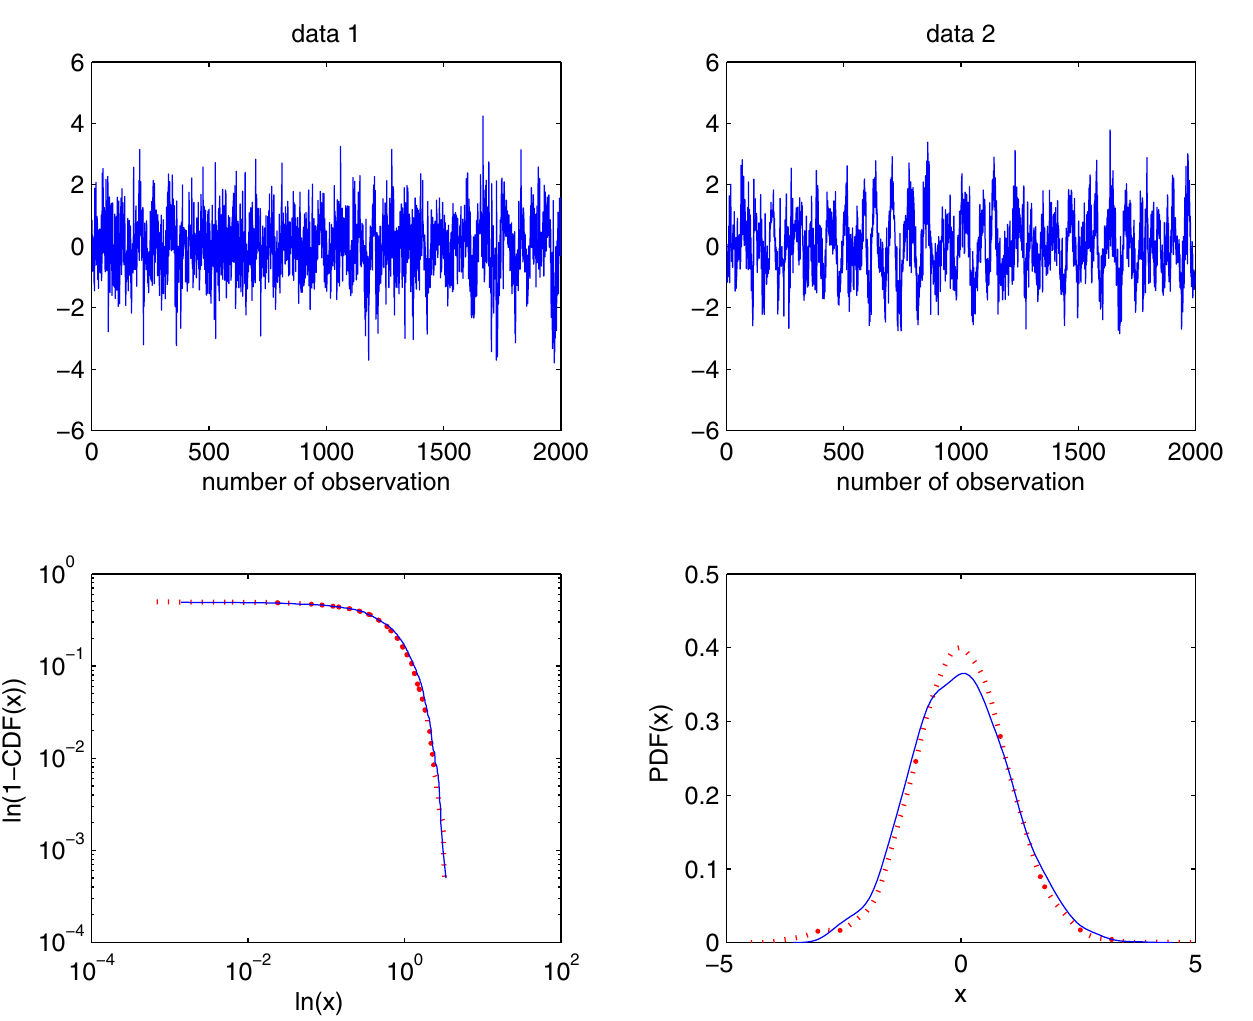
Fig 11. Plasma data for the torus radial position r = 9.5 cm: data1 (top left panel), data2 (top right panel), and their empirical tails (bottom left panel) and PDFs (bottom right